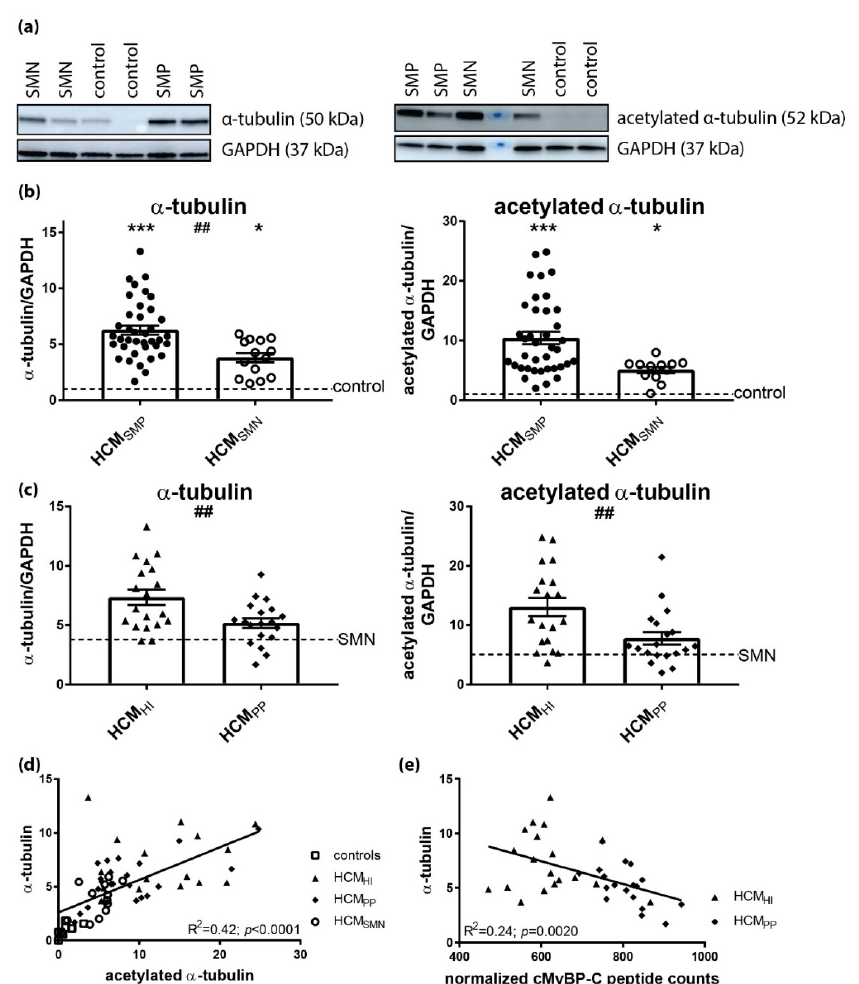
Figure 6. Pathomechanism of HCM and acetylation of α -tubulin. ( a ) Representative blot images for α -tubulin and acetylated α -tubulin. ( b ) Higher levels of α -tubulin and acetylated α -tubulin in HCM SMP ( n = 38) and HCM SMN (α -tubulin: n = 14; acetylated α -tubulin: n = 12) compared to controls. Significant difference of α -tubulin levels between HCM SMP and HCM SMN (##p < 0.01). ( c ) Higher levels of α - tubulin and acetylated α -tubulin in HCM HI ( n = 19) than HCM PP ( n = 19). ( d ) The levels of α - tubulin correlated well with acetylated α -tubulin ( e ) Significant inverse linear correlation of α -tubulin with cMyBP-C. Controls = open squares, HCM SMP = filled circles, HCM SMN = open circles, HCM HI = filled triangles, HCM PP = filled rhomboids. Each dot in the scatter plots and the correlation analyses represents an individual sample. * p < 0.05 and *** p < 0.001 versus controls and ## p < 0.01 and ### p < 0.001 versus HCM PP .